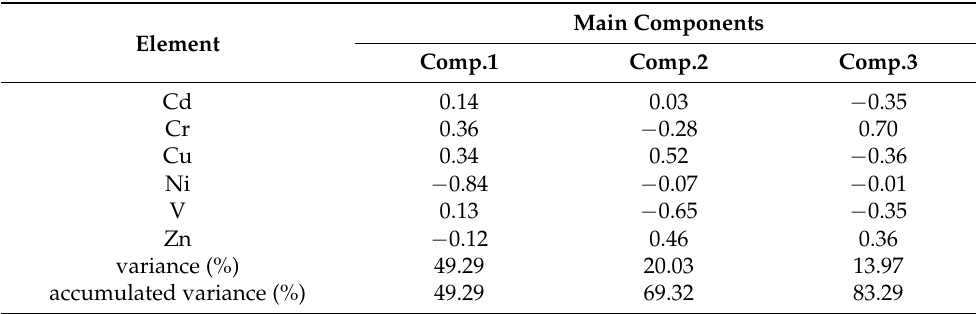
Table 4. Factor matrix, Principal Component